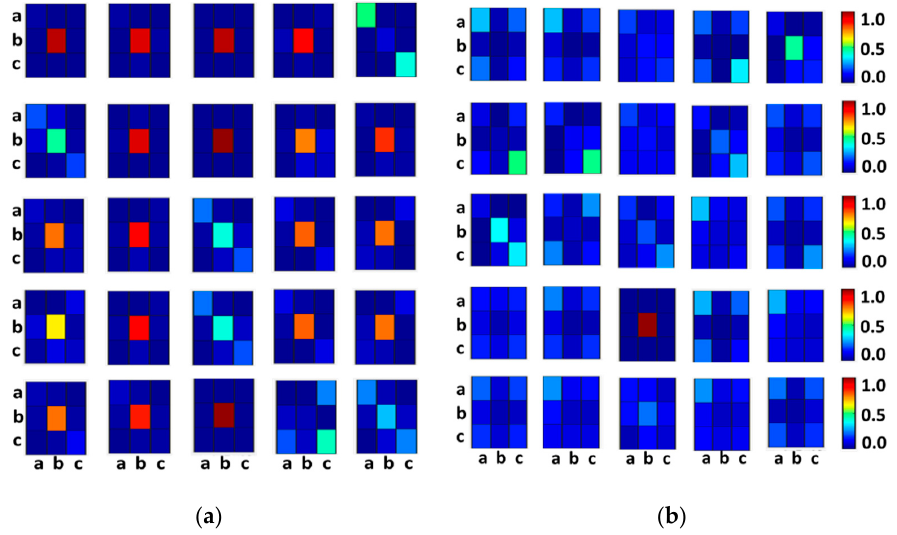
Figure 6. Representative heatmaps of transition patterns for SR ( a ), and PAF ( b ) segments using co-occurrence matrices.